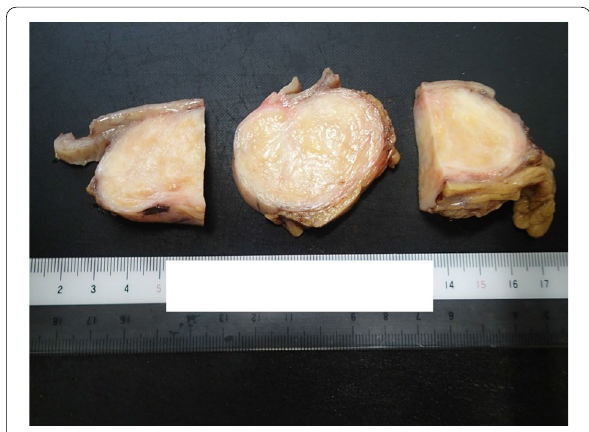
Fig. 2 The cut surface of the tumor revealing a well‑circumscribed yellowish‑white solid mass